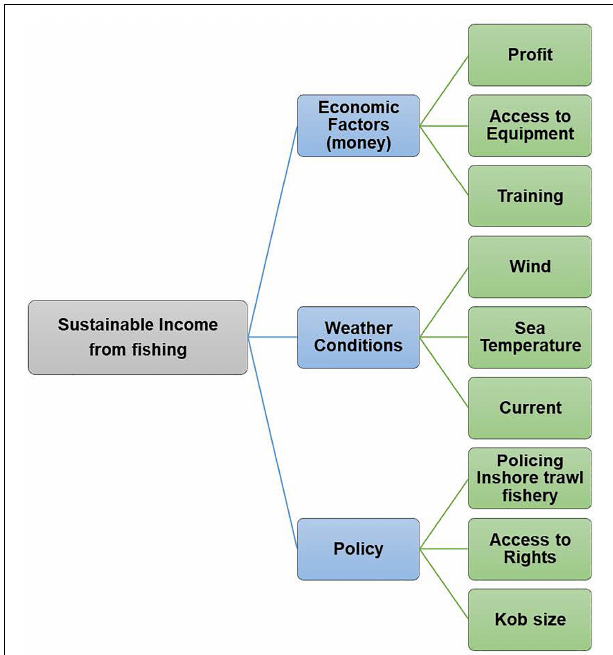
FIGURE 4 | Hierarchy of drivers identified by participants. This hierarchy, with no weightings and states, provide the blueprint for the BBN structure. Note however, that the influences of the principal drivers become the root nodes in the